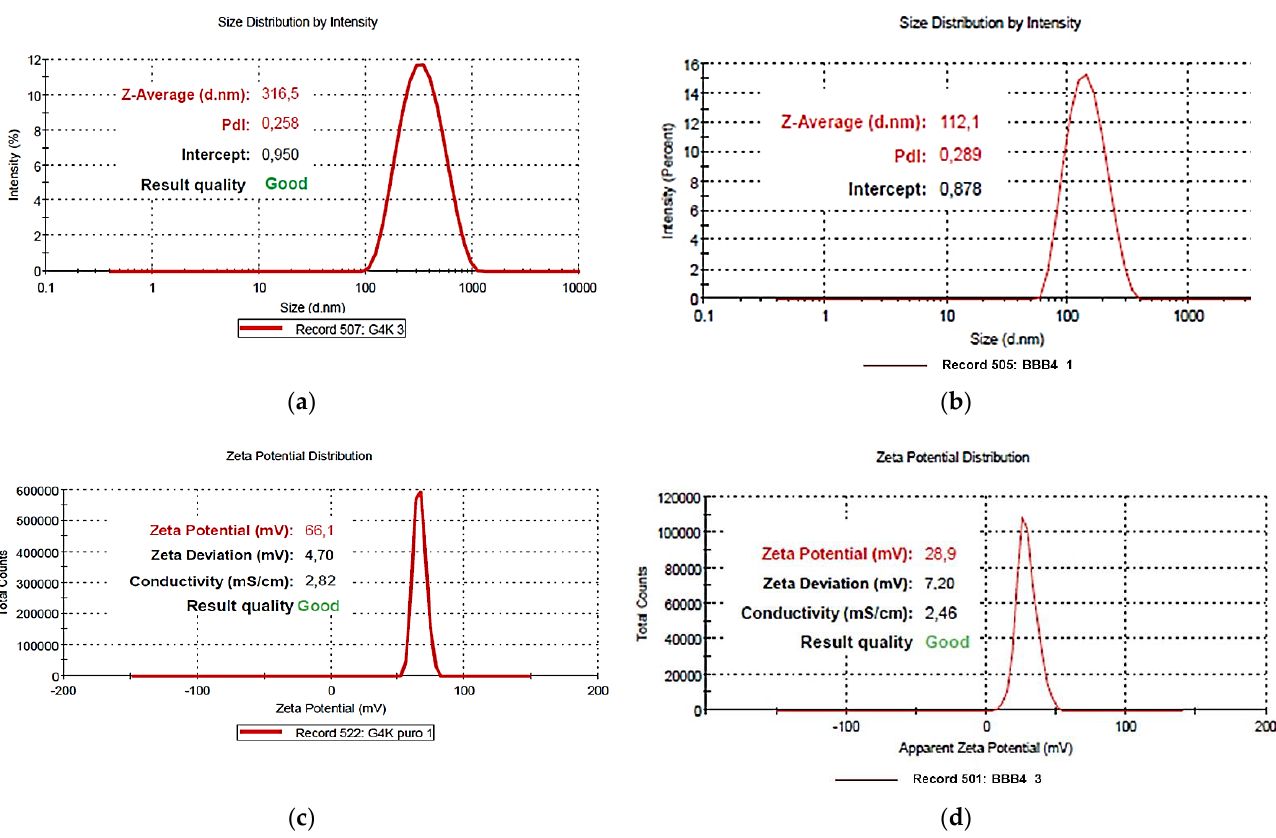
Figure 13. Representative particle size distributions of G4K ( a ) and of BBB4-G4K ( b ) and representative ζ - p distributions of G4K ( c ) and BBB4-G4K ( d ).